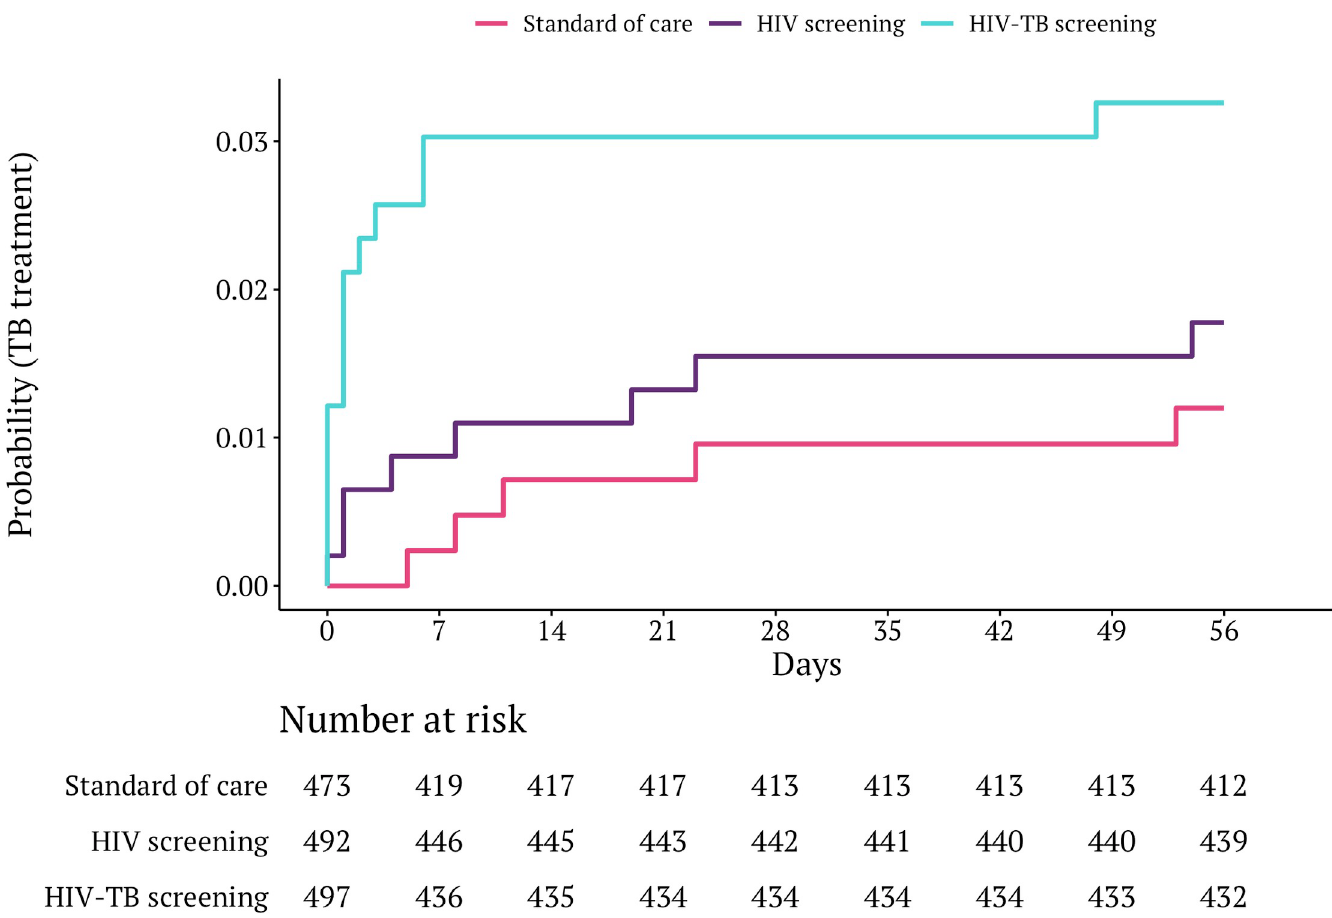
Fig 3. Time to initiation of TB treatment by trial arm. TB,